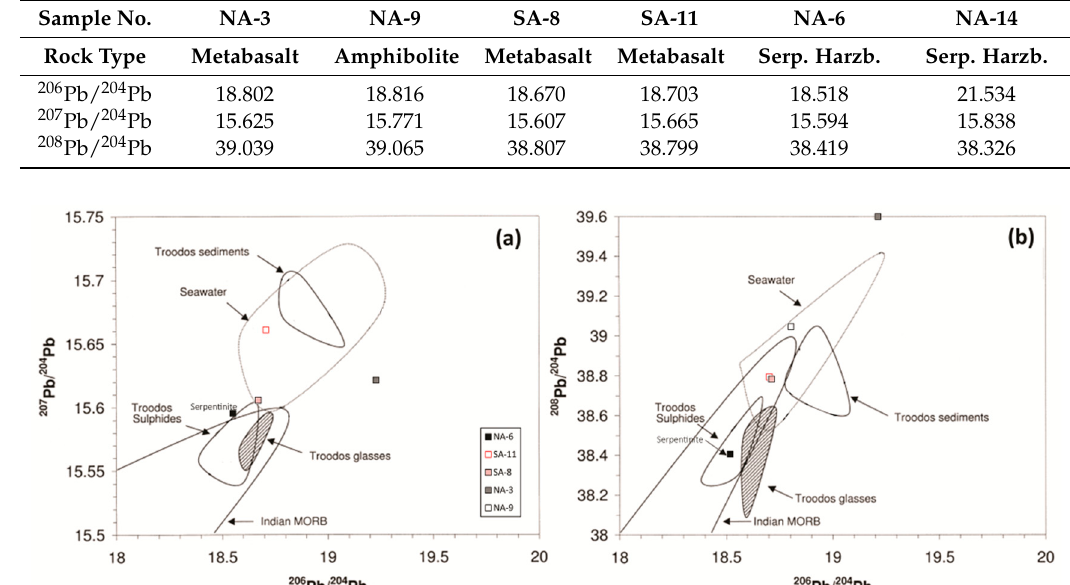
show wide variation, from close to MORB into the seawater field. The elevated 207 Pb/ 206 Pb and the